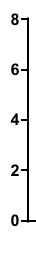
Figure 9. Total circulating ROS/RNS in CAD and control group. Box-and-whisker plot represents circulatory total ROS/RNS in CAD (n = 22) and control group (n = 15) with median (IQR), max/min and dots are average values of total ROS/RNS. Average values obtained from experimental triplicates. Significance between the groups was assessed by Mann–Whitney U test. Data is represented in Box-and-whisker plot with median (IQR), min/max.; dots represent average values of the parameters obtained from experimental triplicates; p ≤ 0.05 considered statistically significant.